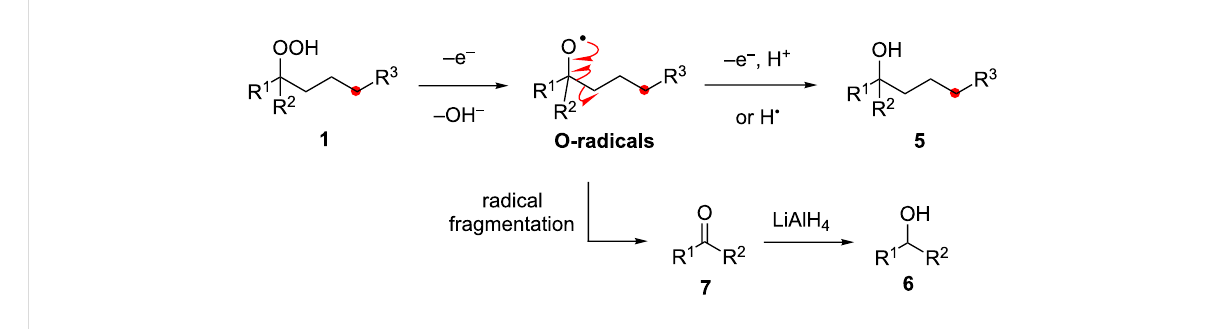
Scheme 4: Proposed reaction mechanisms for the formation of 5 and 6 .